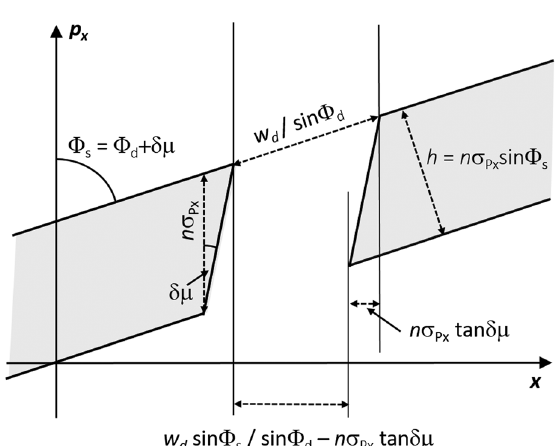
FIG. 21. Analytical estimates of 400 GeV =c normalized loss contributions vs diffuser position for a 0.5-mm-wide ES and